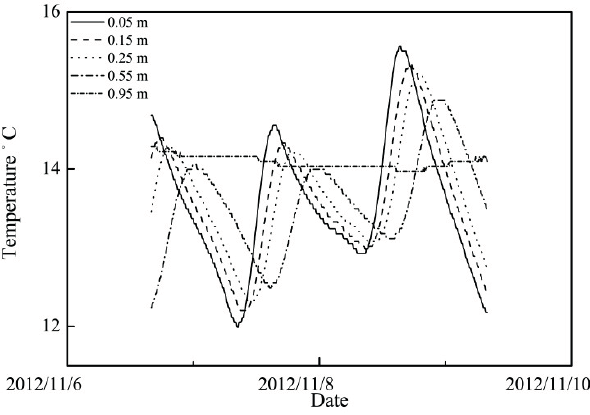
Fig. 3 Temperature time series at various depths below the